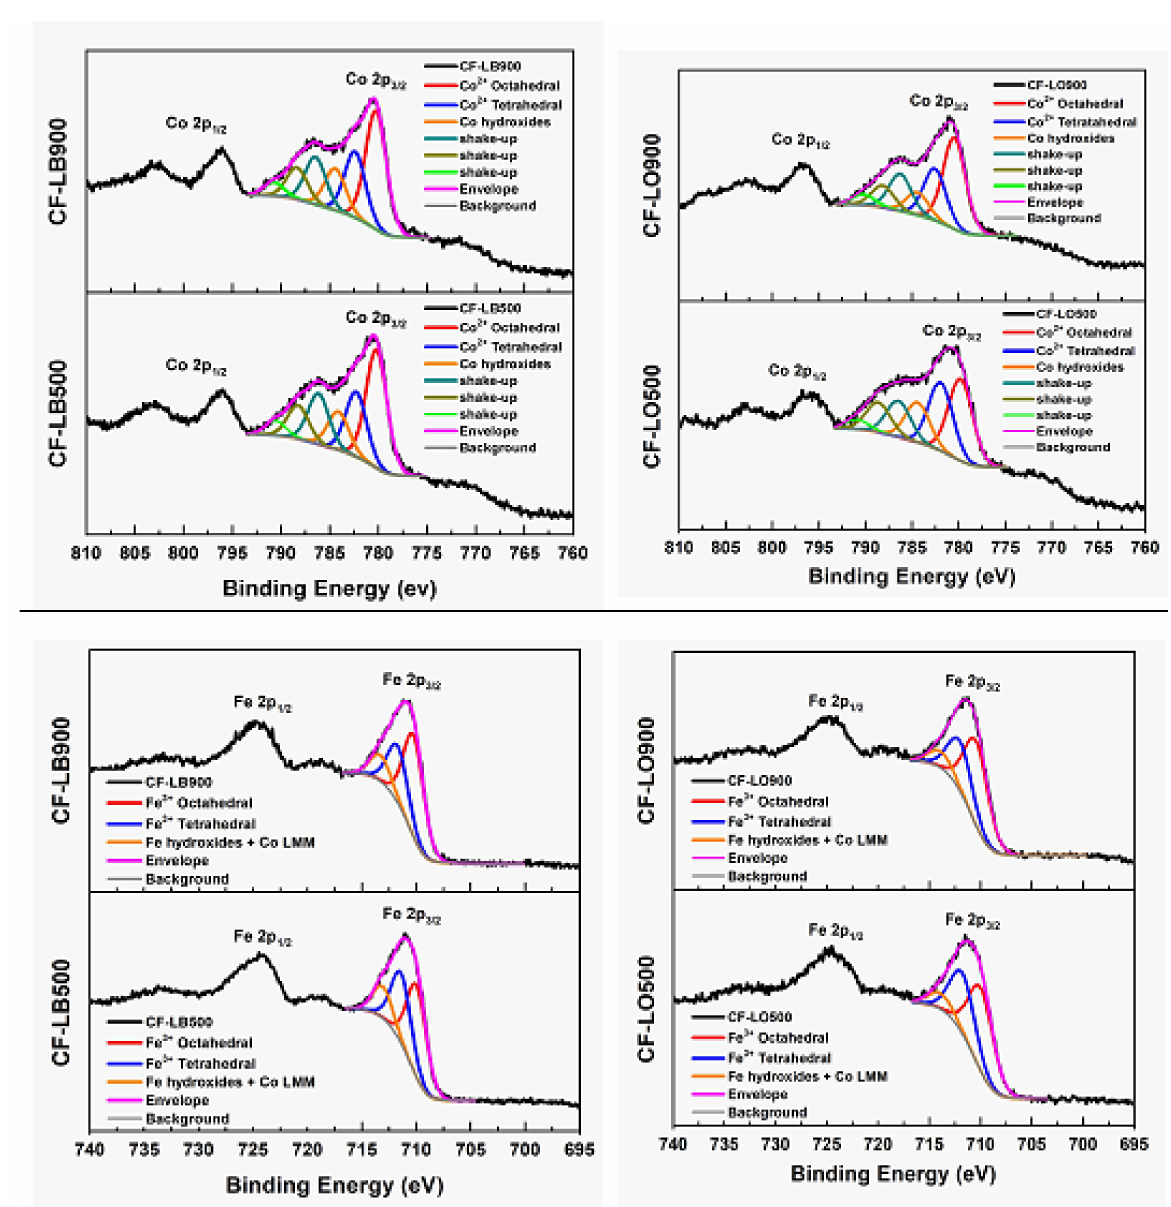
Figure 6. Deconvolution of Co and Fe XPS spectra of the hybrids samples obtained at 500 ◦ C ( bottom ) and at 900 ◦ C ( top